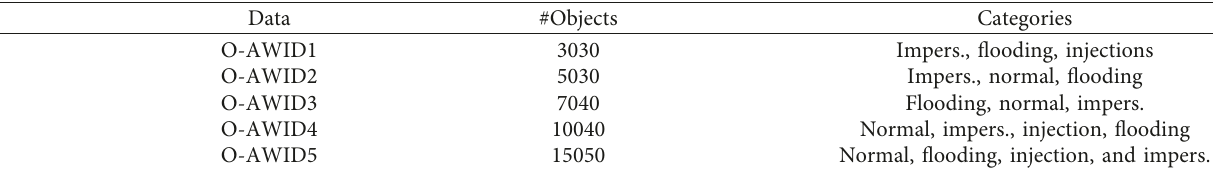
Table 2: Main characteristics for FLDS and LOF.